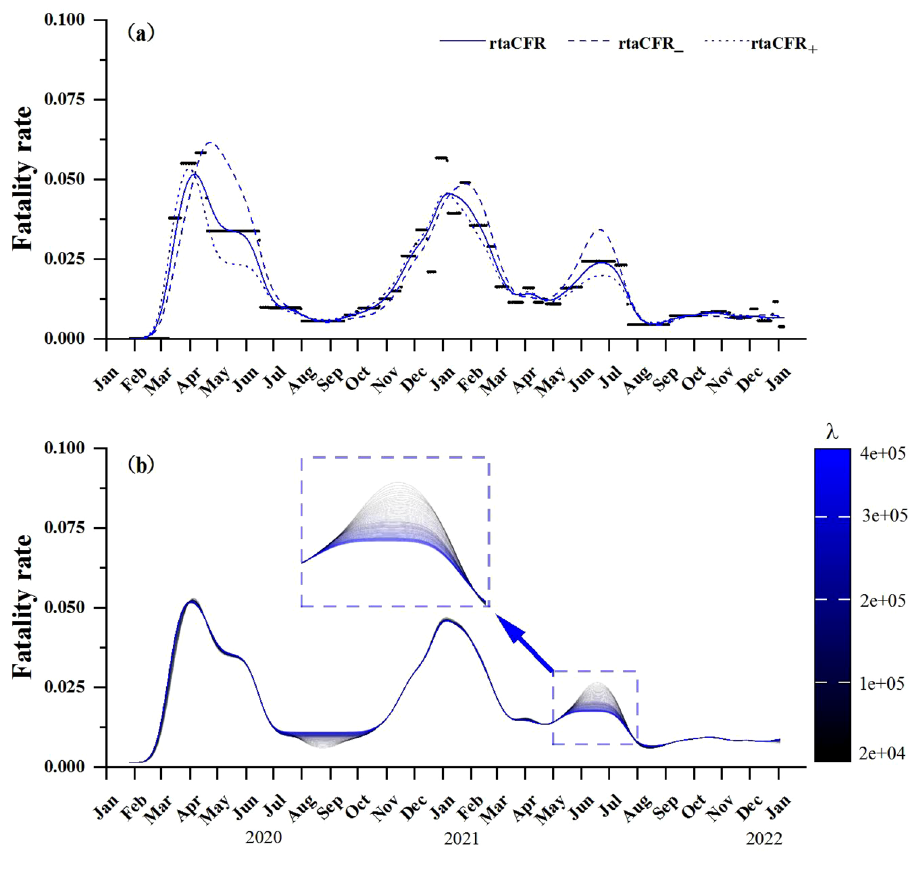
Figure 3. Estimation for the COVID-19 data in Germany ( a ) original rtaCFR (piecewise constant black lines) plus smoothed rtaCFR (blue lines) based on different Gamma distributions for F , using the optimal tuning parameter; ( b ) smoothed rtaCFR obtained based on different tuning parameter values for sensitivity analysis.